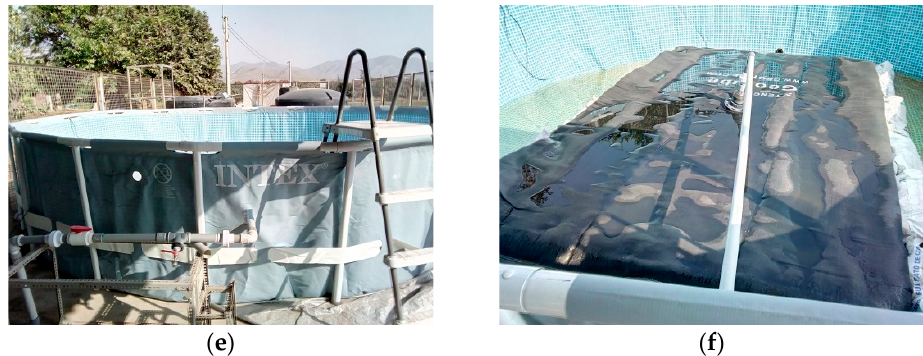
Figure 3. ( a ) Aerial image of the experimental area at INIA. The color of the reservoir water is an indicator of the concentration of algae. Water treatment plant images: ( b ) pumping system of the Rímac River water reservoir; ( c ) dosing pumps, ( d ) serpentine mixer, ( e ) treated water reservoir, ( f ) geotube.